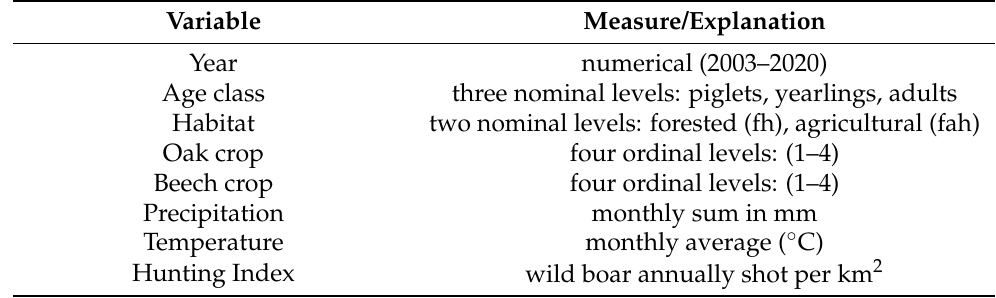
Table 2. Predictors of wild boar body weight used in this